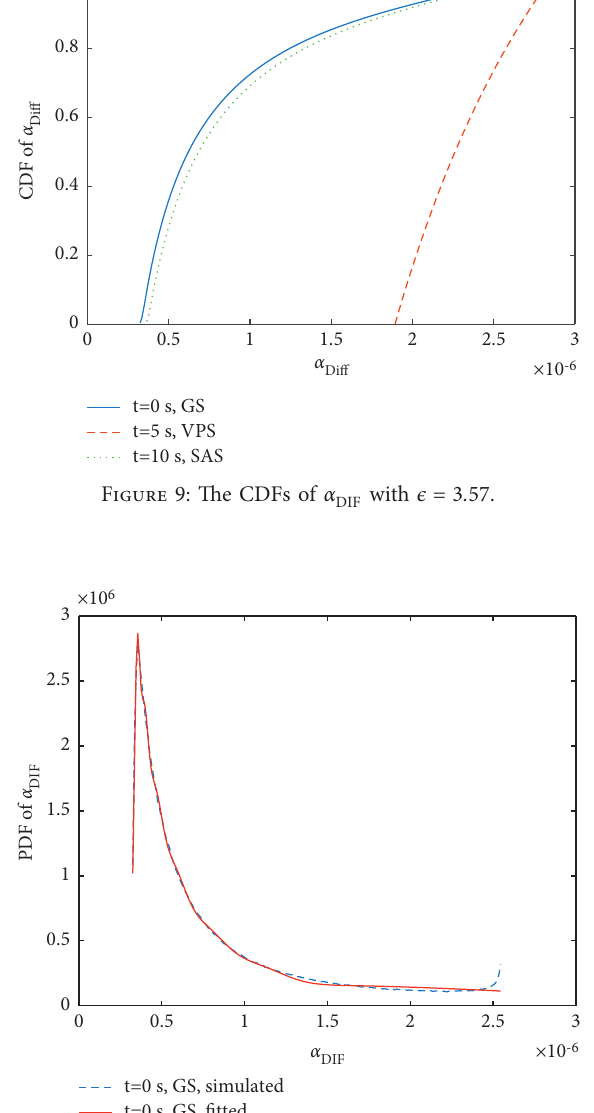
Figure 10: The PDF of α and its fitted function (with t � 0 s, GS, and ϵ � 3 . DIF